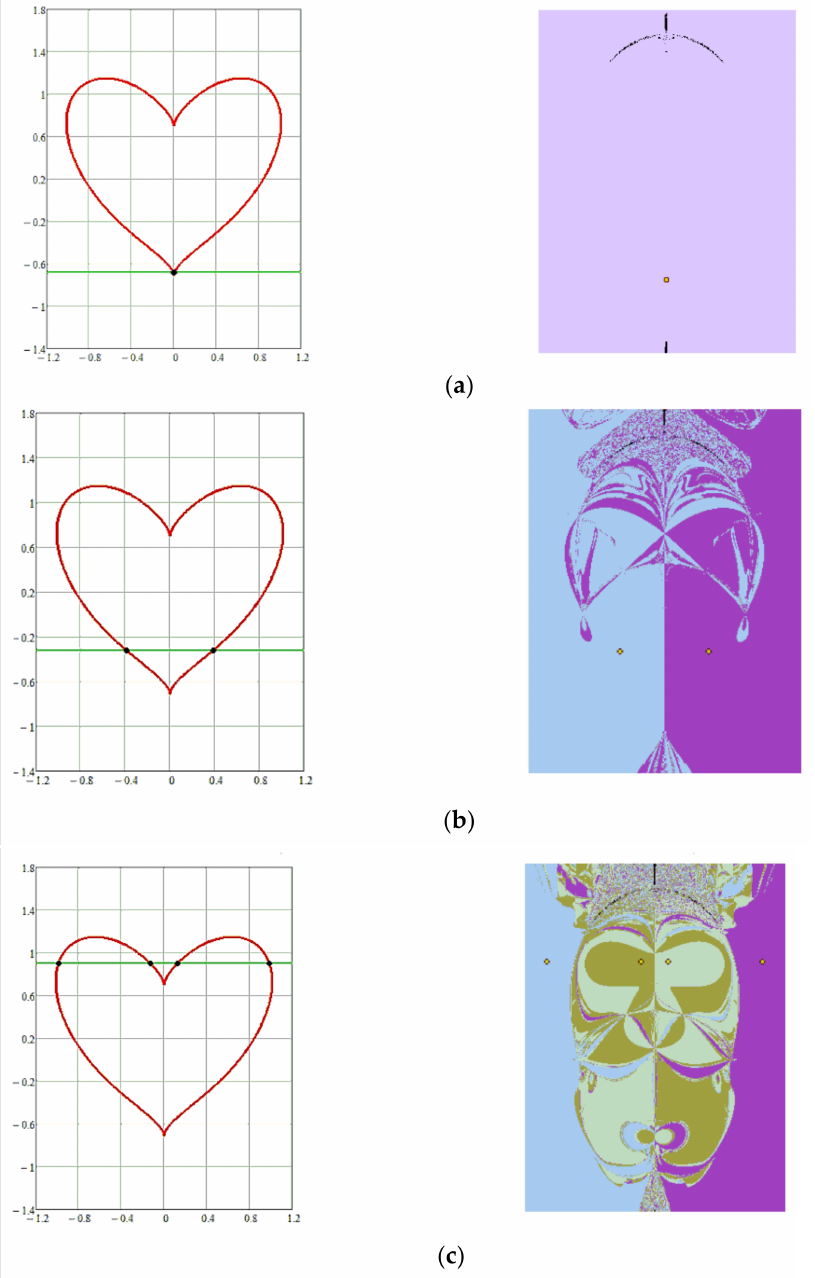
Figure 16. “Portrait” of the roots of the system of Equation (3), obtained by the Levenberg–Marquardt method, for one ( a ), two ( b ) and four ( c )